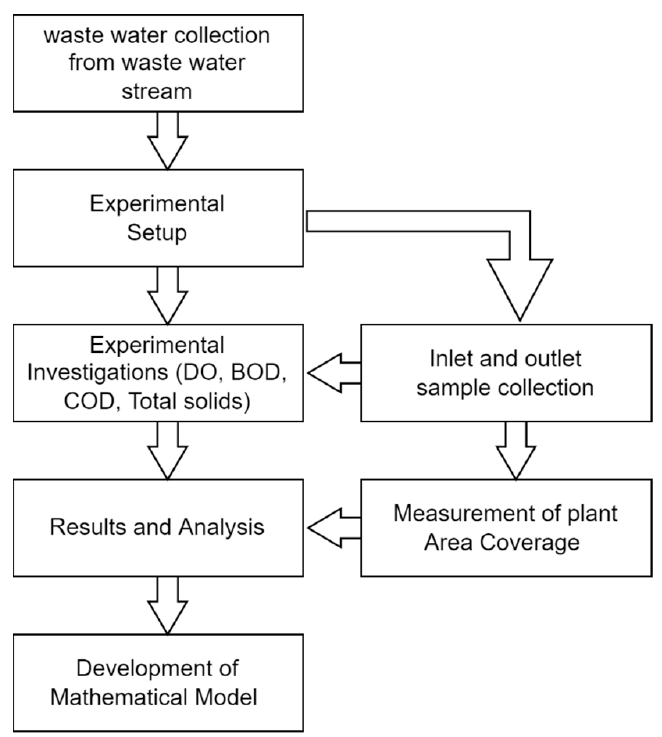
Figure 2 . Flow chart for Methodology . Figure 2. Flow chart for